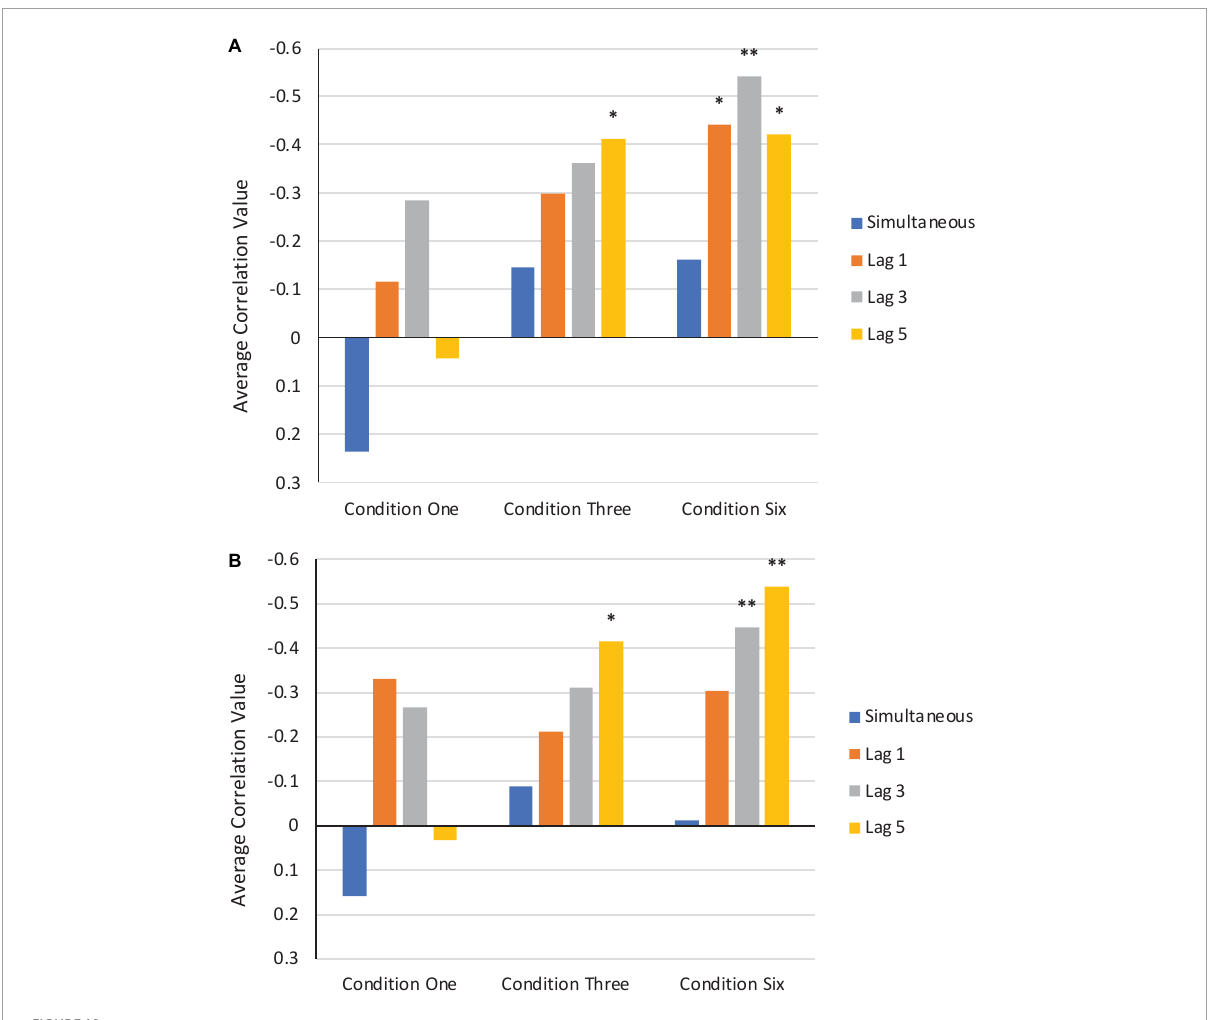
FIGURE10 Average bivariate correlations in F1 (A) and F2 (B) between perturbation values applied in the Perturbation phase of Condition One, Condition Three, and Condition Six and participants’ normalized production values. Simultaneous correlations are shown in blue. Correlations at trial lags of one, three, and five are shown in orange, gray, and yellow, respectively. ∗ Correlation is significant at the 0.05 level. ∗∗ Correlation is significant at the 0.01